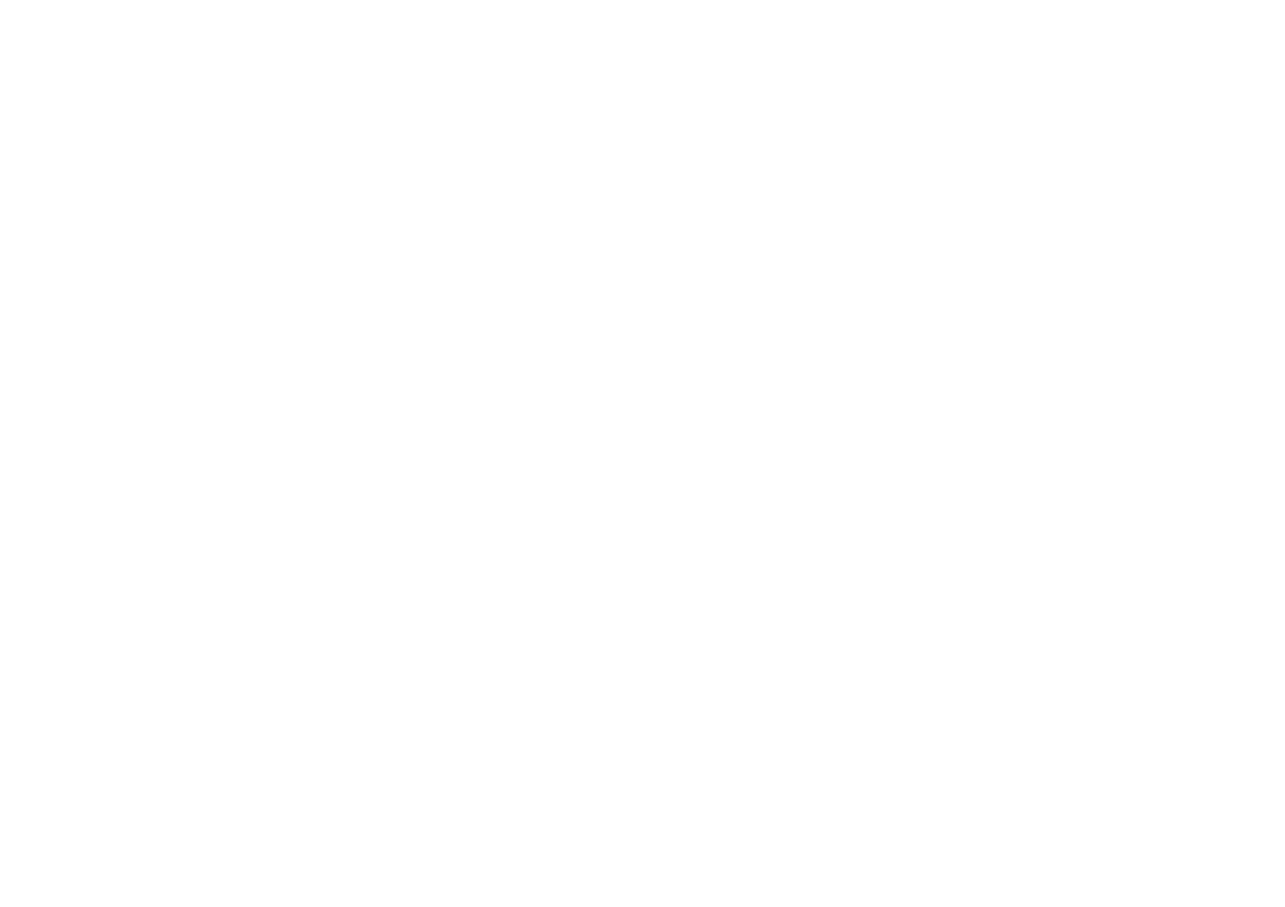
Frontiers in Medicine |